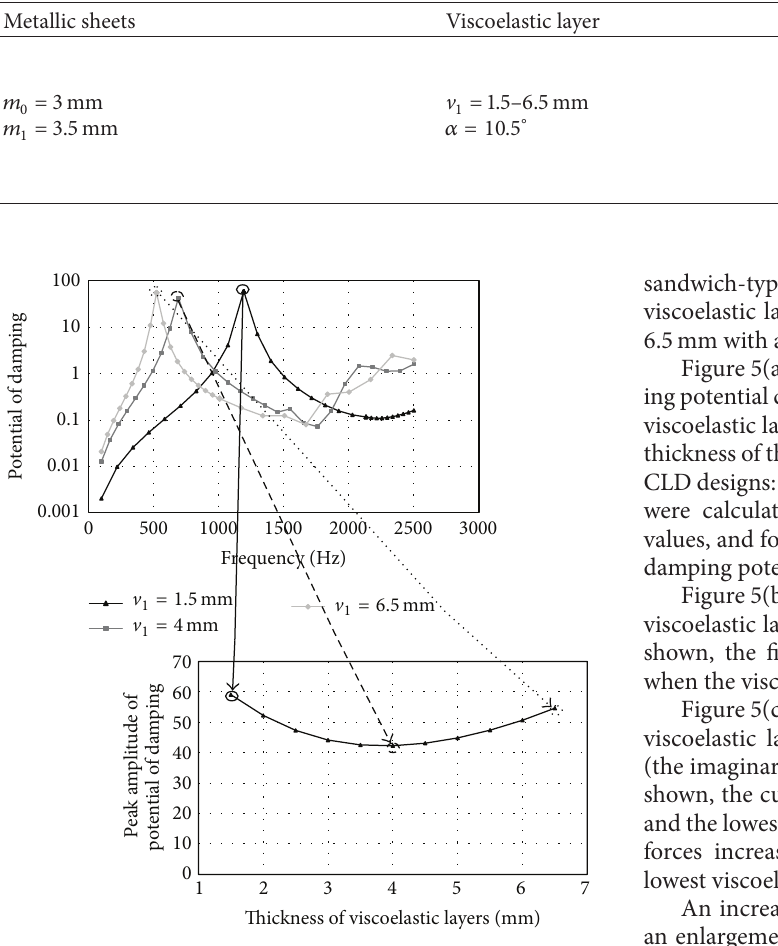
Figure 4: Damping potential of a monolayer damper for different thickness of the viscoelastic